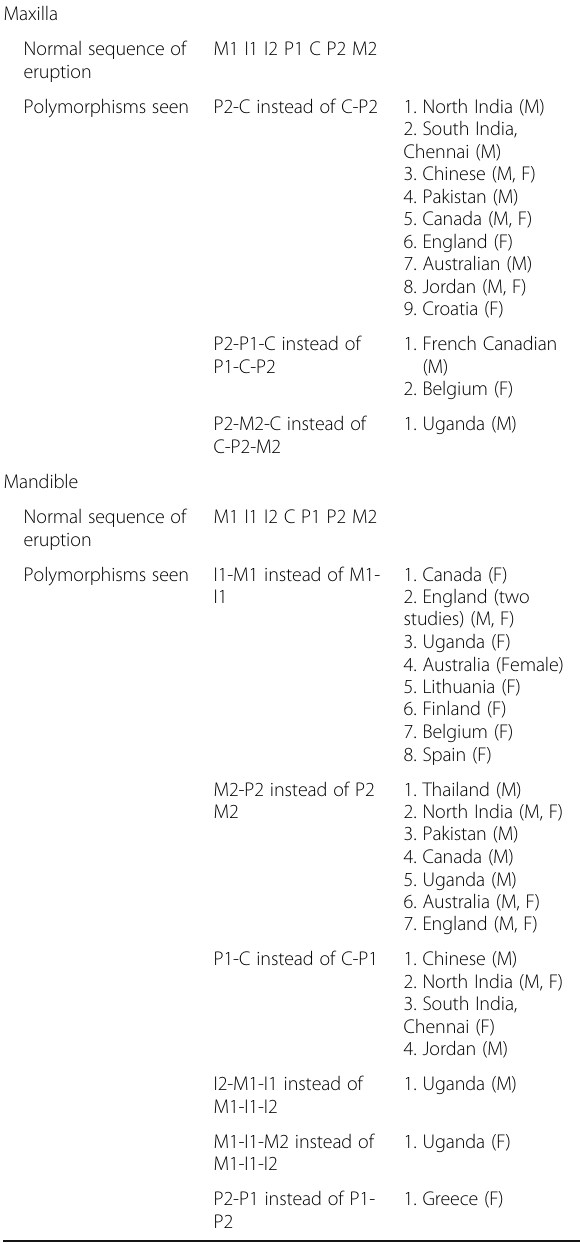
Table 3 Sequence of eruption of maxillary and mandibular teeth with the list of polymorphisms in the eruption seen in different populations Maxilla Normal sequence of